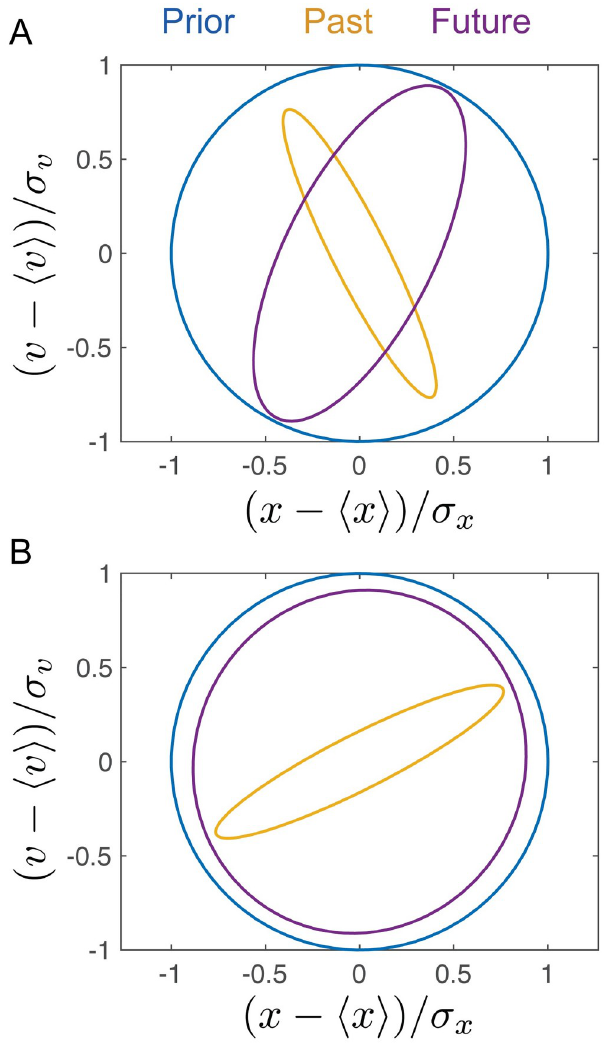
Fig 5. Example of a sub-optimal compression. An optimally predictive, compressed representation, in panel (a) compared to a suboptimal representation, in panel (b) for a prediction at Δ t = 1 in the future, within the underdamped regime ( z = 1/2). We fix the mutual information between the representations and X t ( I ð X as expected, the suboptimal representation contains significantly less information about the future.